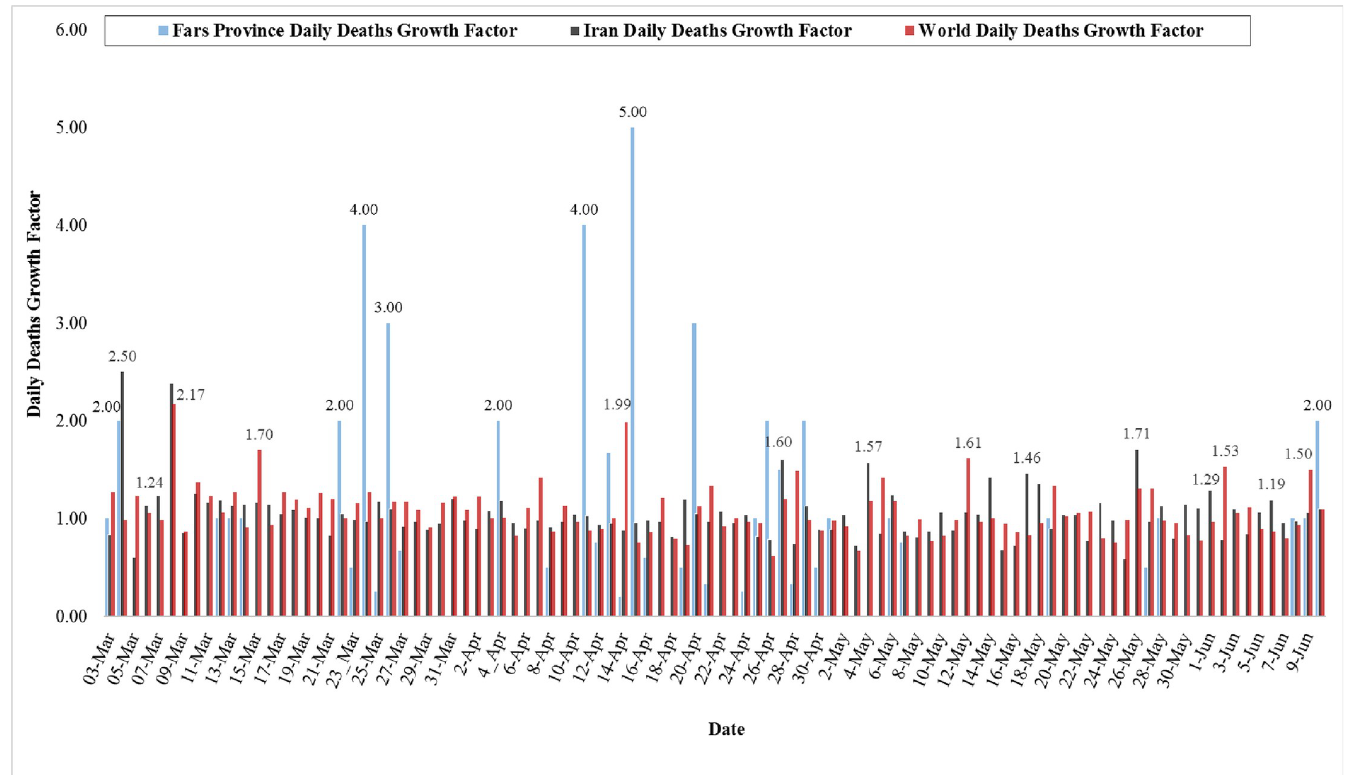
Fig 9. Growth rate of death cases in the world, Iran, and Fars Province (From 2 March to 10 June 2020).